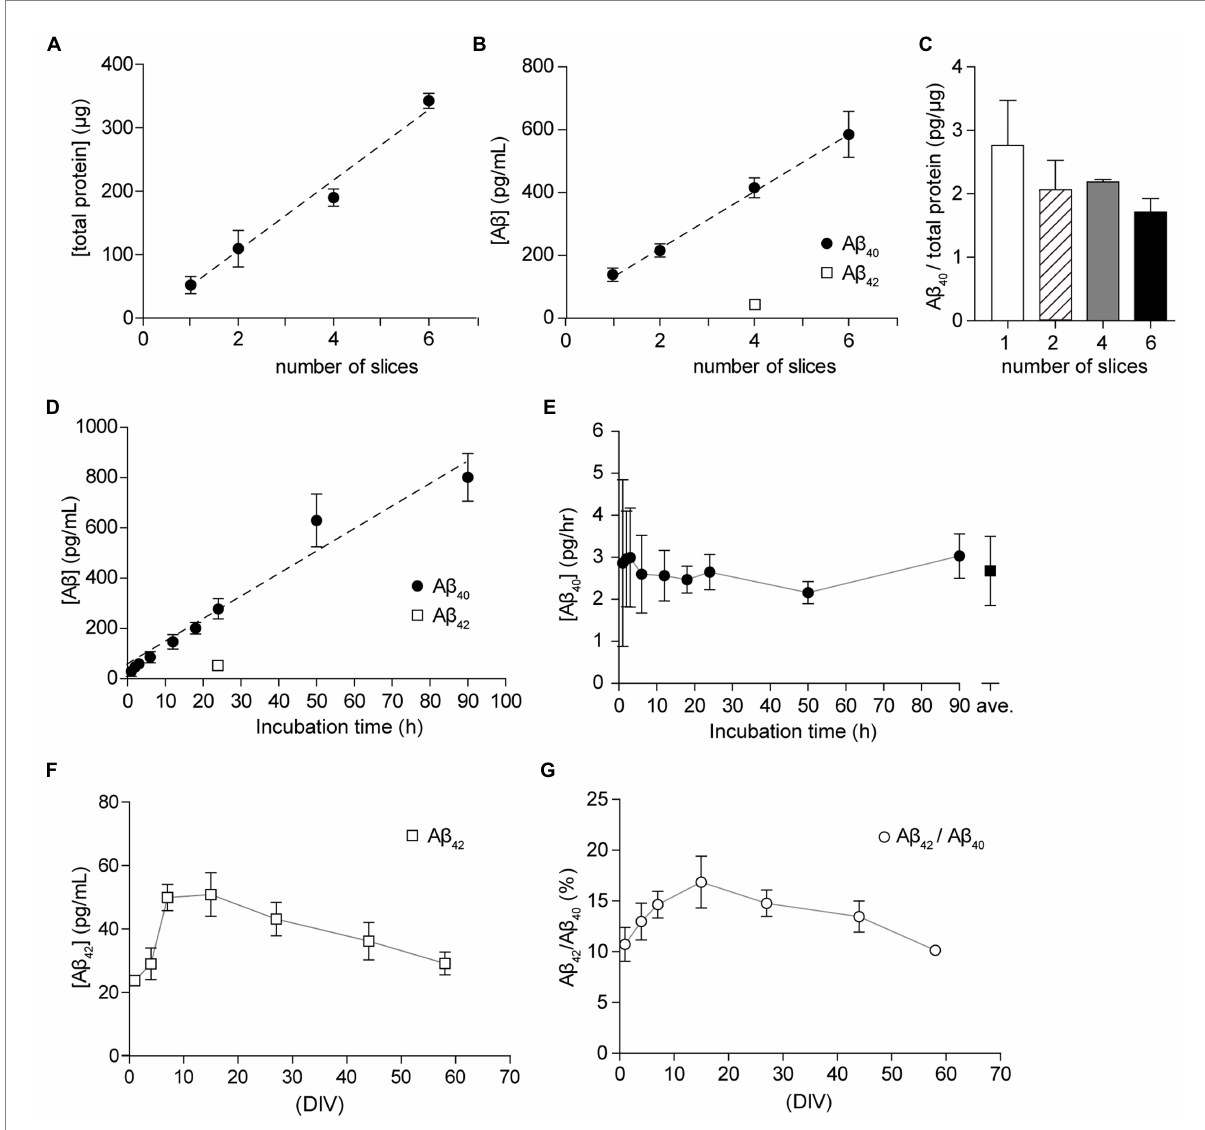
FIGURE 4 Culture condition and period dependency of the secretion of A β 40 . (A) Total protein in the lysate from 1, 2, 4, or 6 hippocampal slices (filled circles). Dashed line; linear regression. R 2 = 0.9623, p < 0.0001. (B) Quantification of A β 40 secreted from 1, 2, 4, or 6 cultured hippocampal slices (15 days in vitro , DIV) for 24 h (filled circles). Dashed line, linear regression of A β 40 . R 2 = 0.9607, p < 0.0001. Quantification of A β 42 secreted from 4 cultured hippocampal slices (15 days in vitro , DIV) for 24 h (open square). Results are presented as mean ± SD based on three independent experiments ( n = 3). (C) The ratio of A β 40 to total slice protein. Open bar, 1 slice; stripe bar, 2 slices; gray bar, 4 slices; black bar, 6 slices. Statistical significance was tested by one-way ANOVA, and pairwise comparison was performed according to Tukey–Kramer multiple comparison test. There was